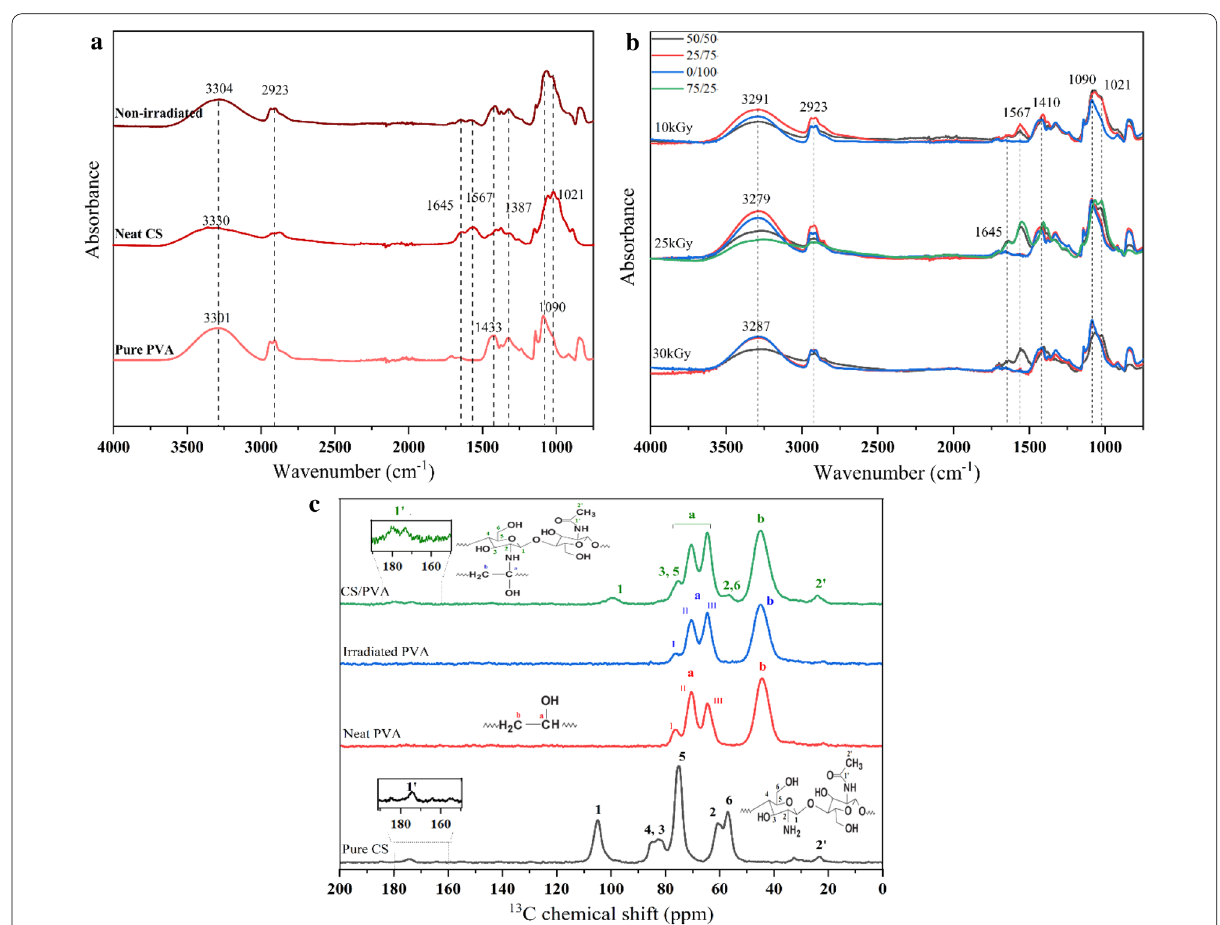
Fig. 4 a Fourier transform infrared spectra of pure PVA, neat CS, non-irradiated CS/PVA, and b FTIR of crosslinked hydrogels irradiated at 10, 25, and 30 kGy; c solid-state 13C nuclear magnetic resonance spectrum of pure CS, neat PVA before and after irradiation, and the 50/50 CS/PVA hydrogel